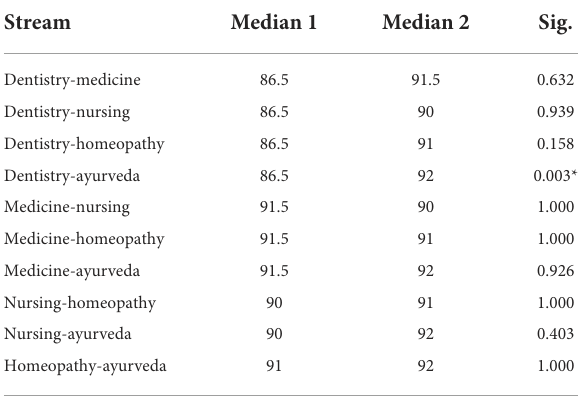
Table 3 Known group validity based on healthcare